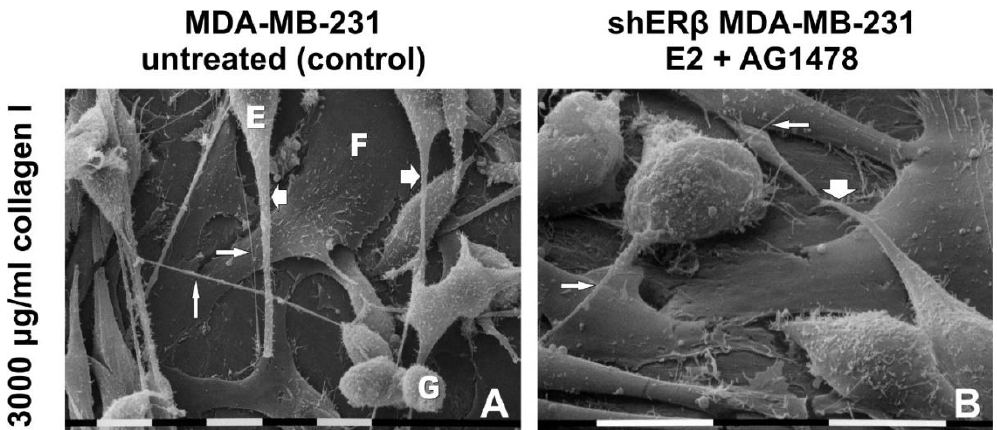
Figure 5. ( A ) Untreated MDA-MB-231 cells cultivated on a Millipore filter coated by 3000 µg/mL type I collagen: Flattened-polygonal cells (F) adhering to the collagen substrate are covered by globular (G) and elongated-fusiform (E) cells exhibiting microvilli and EVs. Long conical-shaped filopodia (large arrows) showing microvilli and EVs on their surface originate from elongated-fusiform cells. Straight intercellular TNTs (narrow arrow) are also present. Bar = 10 µm. ( B ) shERβ MDA-MB-231 cells treated with both E2 and AG1478 (mix) and cultivated on a Millipore filter coated by 3.0 mg/mL type I collagen: Globular and elongated cells showing microvilli on the cytoplasmic surface grow on flattened-polygonal cells just adhering to the collagen layer. A conical filopodia (large arrow) develops from an elongated-fusiform cell. Short straight intercellular TNTs (narrow arrows) are detectable. Bar = 10 µm.